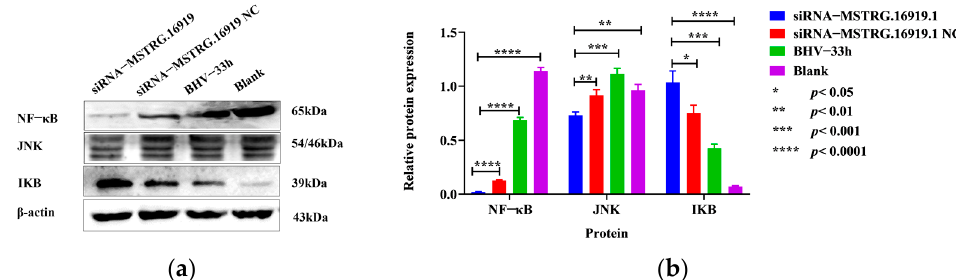
Figure 8. Western blot results. siRNA − MSTRG.16919.1 group is the experimental group in which MDBK cells were infected with BHV − 1 for 33 h and silenced lncRNA − MSTRG.16919.1 ; siRNA − MSTRG.16919.1NC group was MDBK cells infected with BHV − 1 for 33 h and silenced an unrelated sequence, is the negative control group of siRNA − MSTRG.16919.1 group; the BHV − 1 33